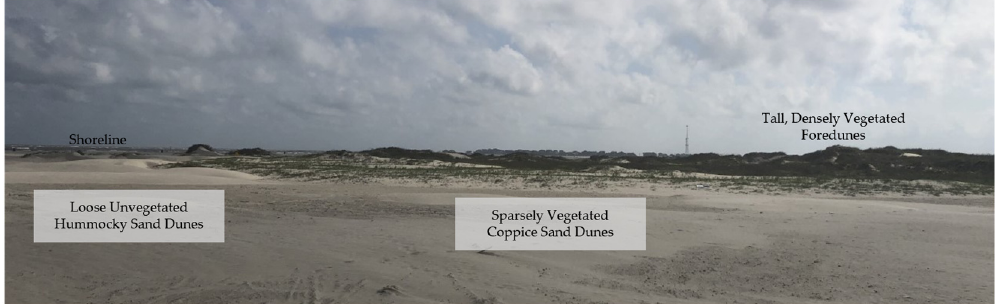
Figure 5. Galveston Site in May of 2022.